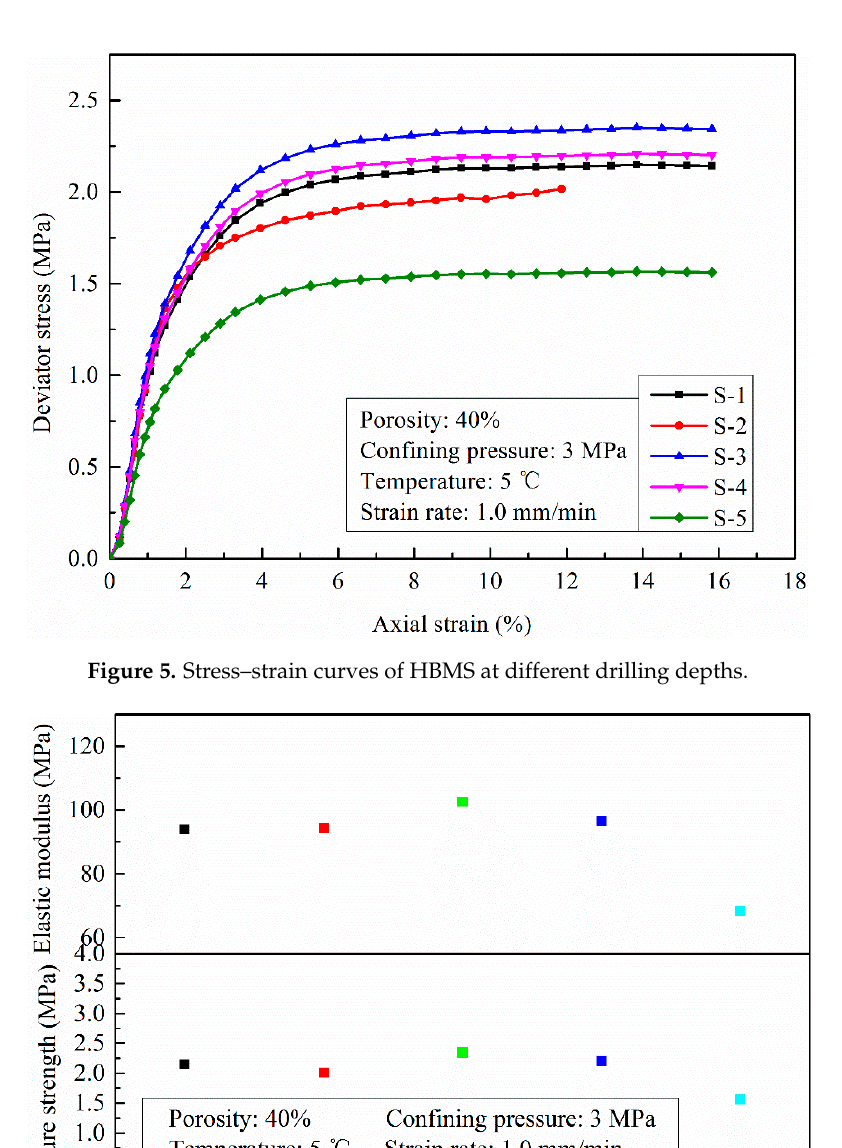
Figure 7. Stress – strain curves of HBMS, hydrate-bearing artificial silt and hydrate-bearing kaolin clay.